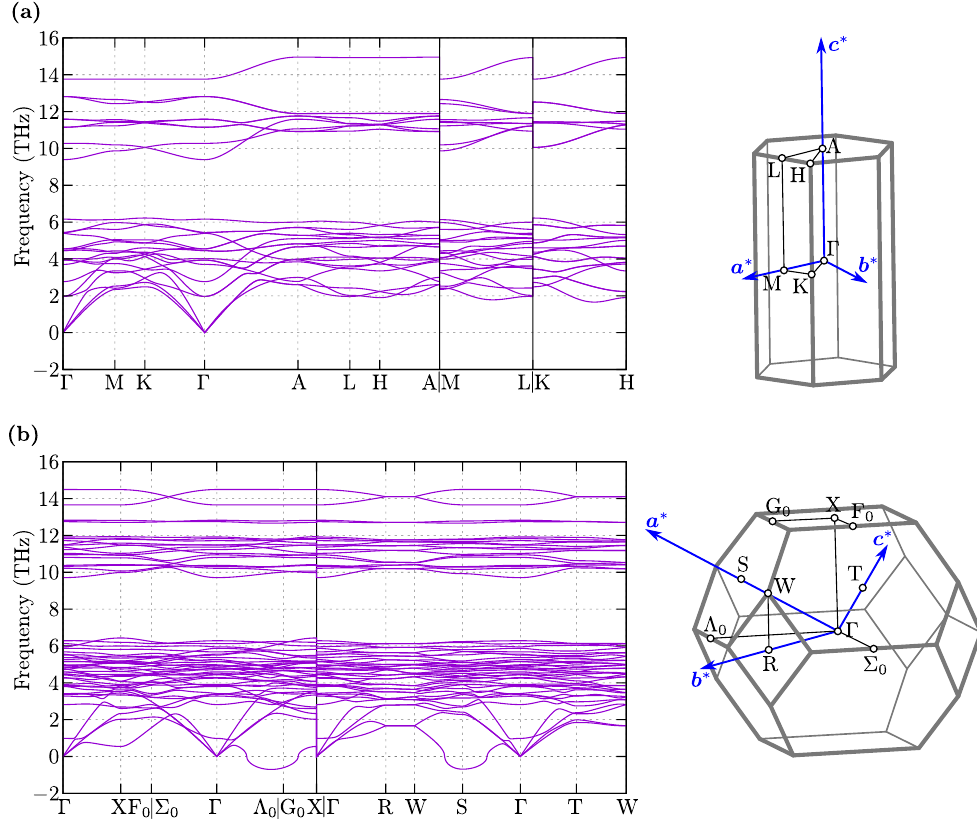
Figure 2. The phonon dispersion along high symmetry directions (left panels) and the Brillouin zone (right panels) for P¯62m ( a ) and Ima2 ( b